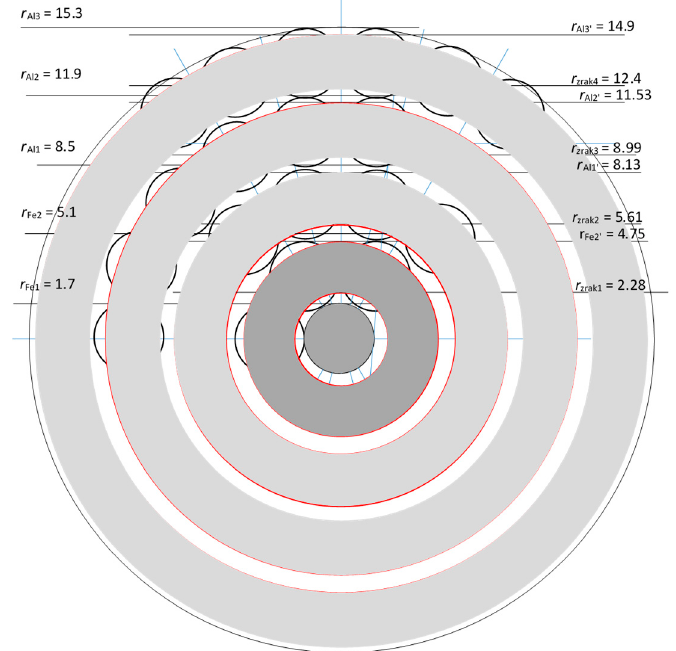
Figure 12. Conductor with drawn replaced rings of air. Note: dark gray—circle and ring of metal (Fe) with the same surface as steel wires; light gray—the metal rings (Al) with the same surface as the wires in the individual layers; white—rings of air with the same surface as the empty spaces between the wires.